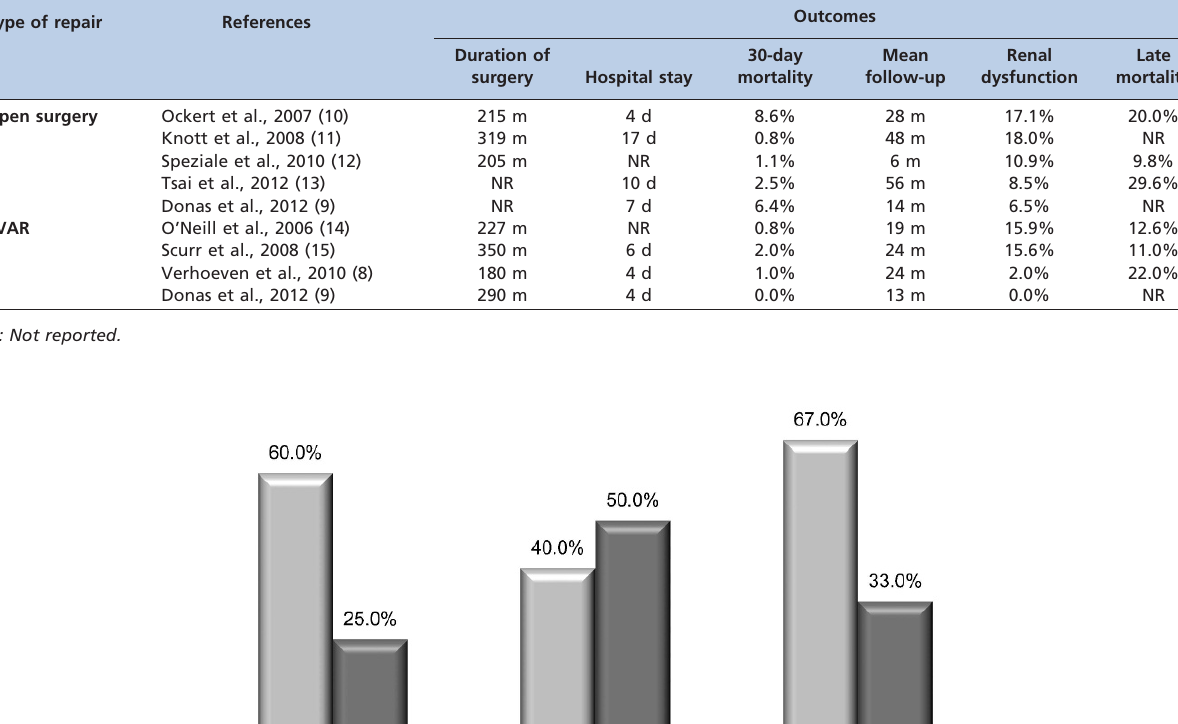
Table 2 - Outcomes reported in the studies on OS or EVAR of the juxtarenal aortic abdominal aneurysms. Type of